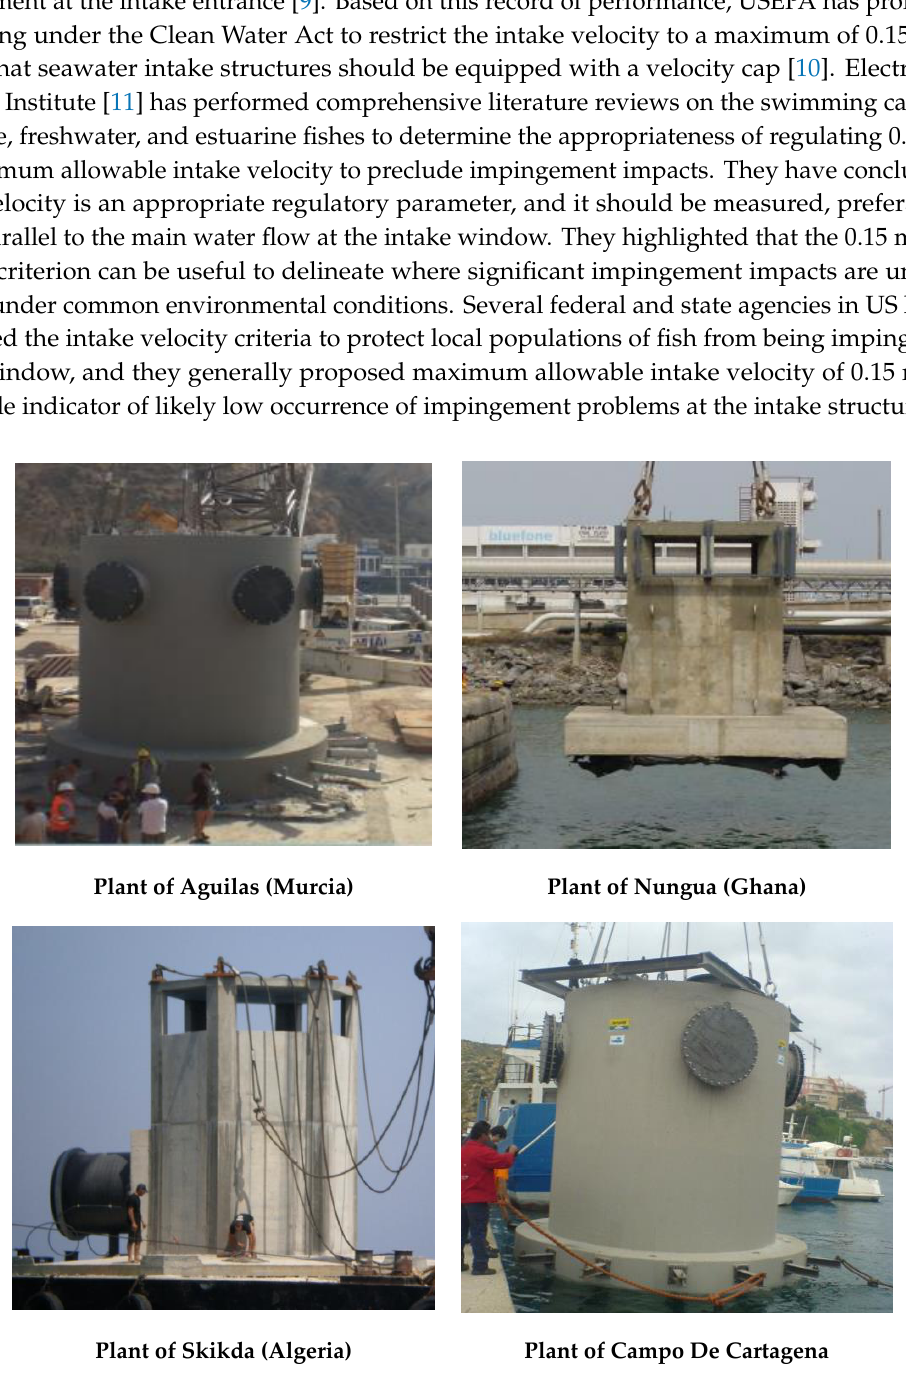
Figure 1. Photo examples of the existing seawater intake structure [1].